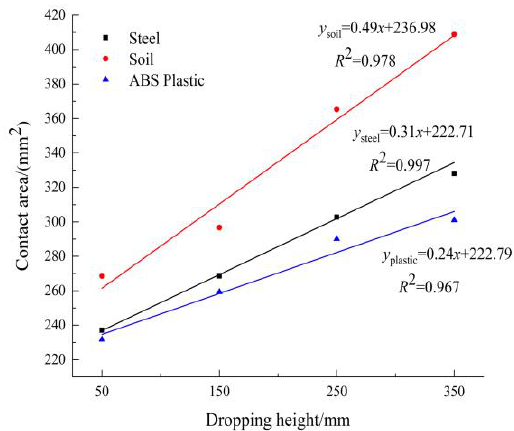
Figure 10. The relationship between contact area and drop height of different contact materials.